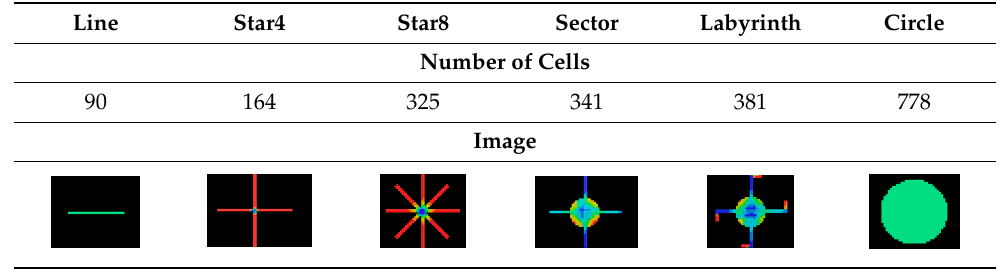
Table 7. Basic meta-pattern values (DepthmapX).